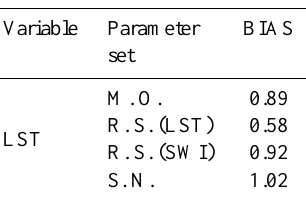
Table 7. The Orba basin. Values of bias on LST series obtained with the different parameter sets. The basin scale mean has been considered.